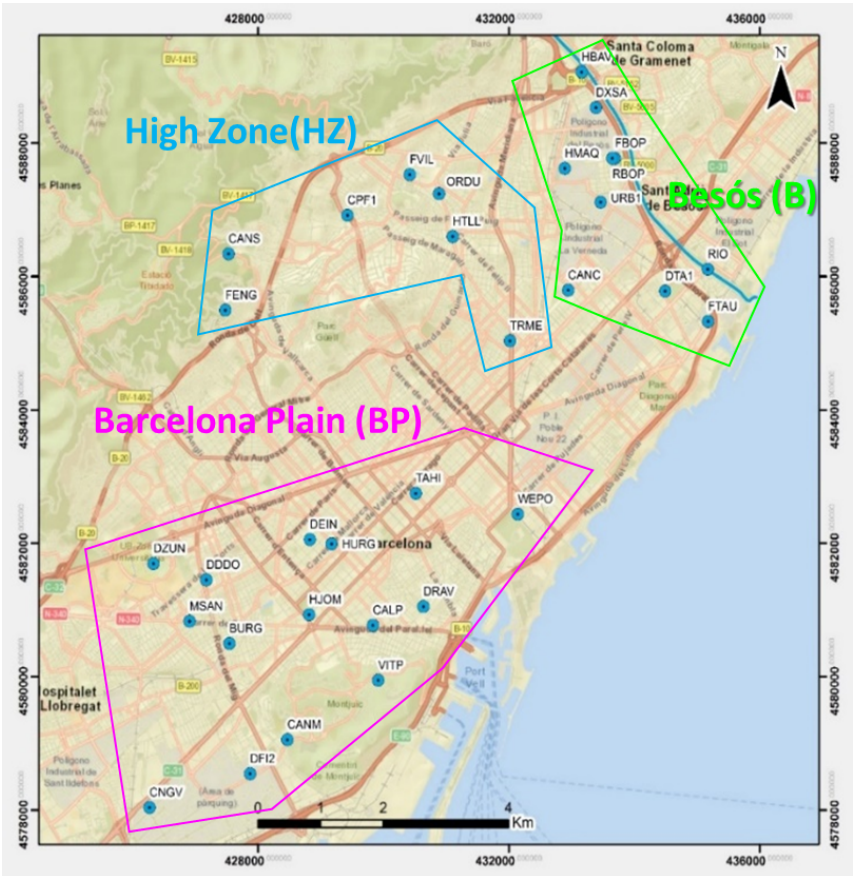
Figure 2. Location of sampled points. Source: © Google